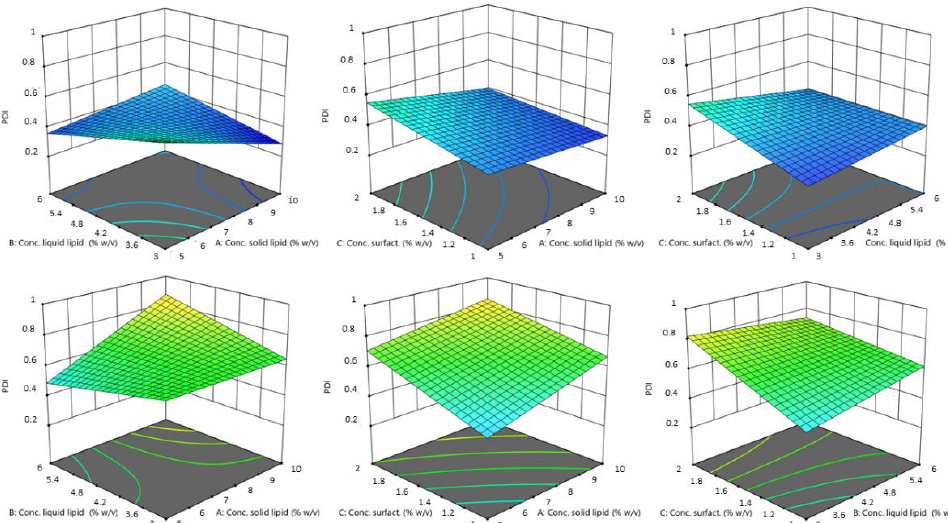
Figure 5. 3D surface of the effect of independent variables (from left to right: solid lipid concn. vs. liquid lipid concn., solid lipid concn. vs. surfactant concn., and liquid lipid concn. vs. surfactant concn.) on the size of NLCs using Softisan ® 100 (top) and Gelucire ® 44/14 (bottom row).